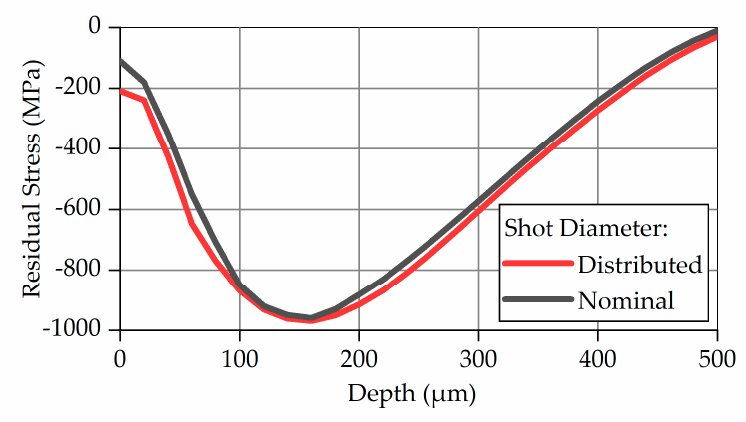
Figure 9. Calculated and simulated values for maximum compressive residual stress.